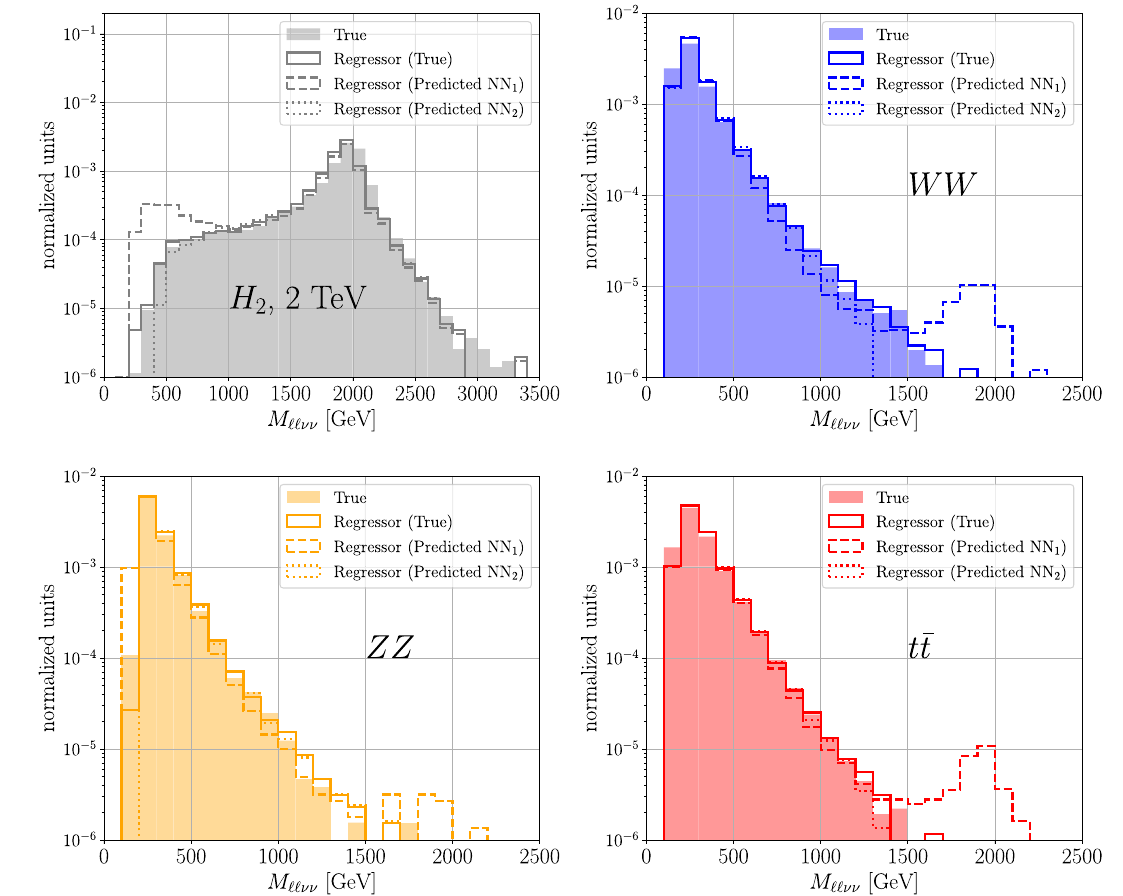
Fig. 11 The true (shaded areas), regressed from true samples (solid lines), regressed from samples identified with NN1 [NN 2 ] (dashed lines) [dotted lines] M (cid:2)(cid:2)νν distributions for the 2 TeV Higgs (upper left), WW (upper right), Z Z (γ ∗ ) (lower left) and t ¯ t background (lower right)